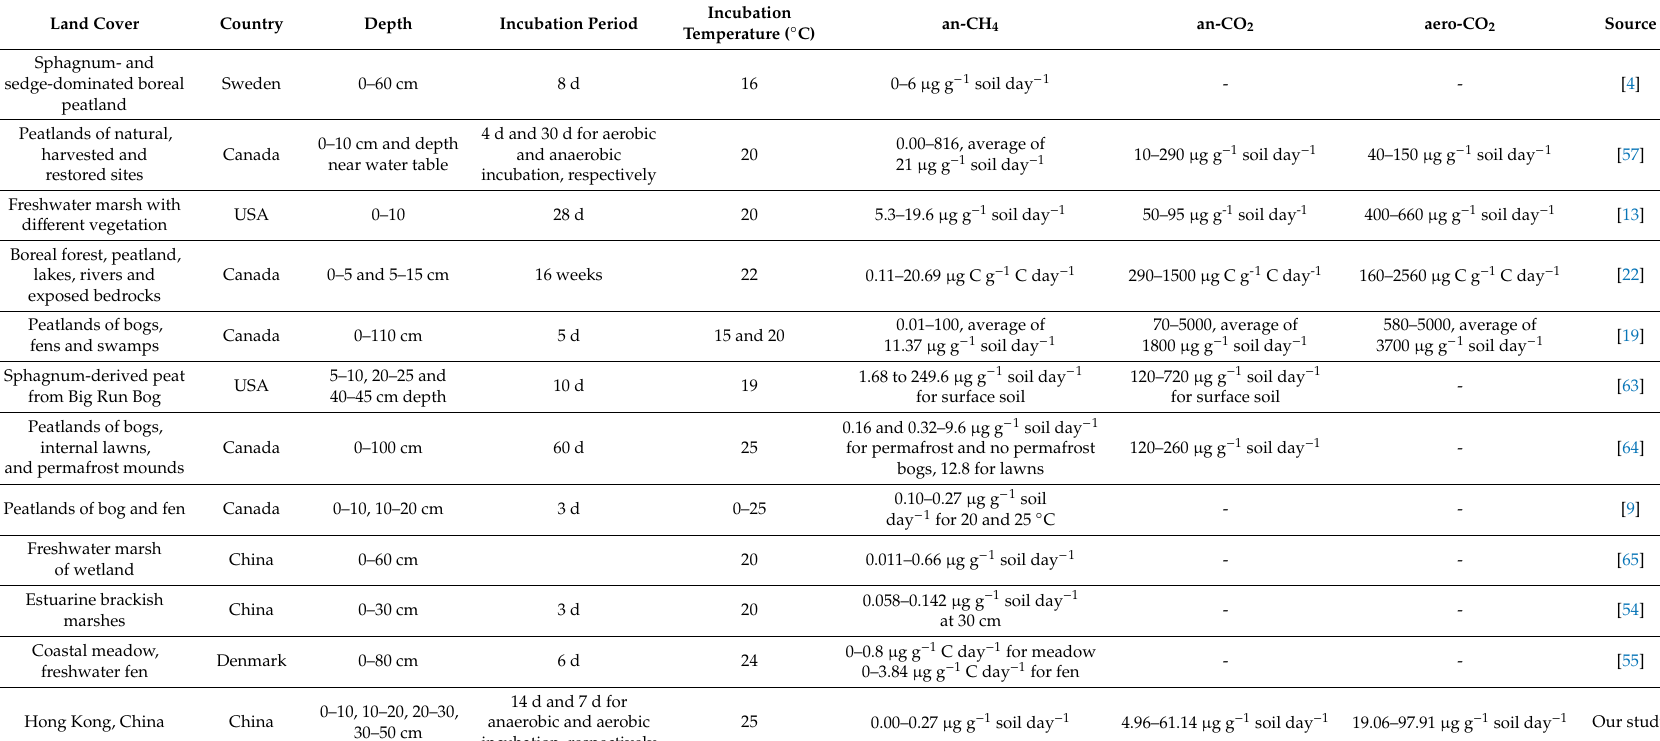
Table 4. A summary of reported values of soil CH 4 and CO 2 production potentials in